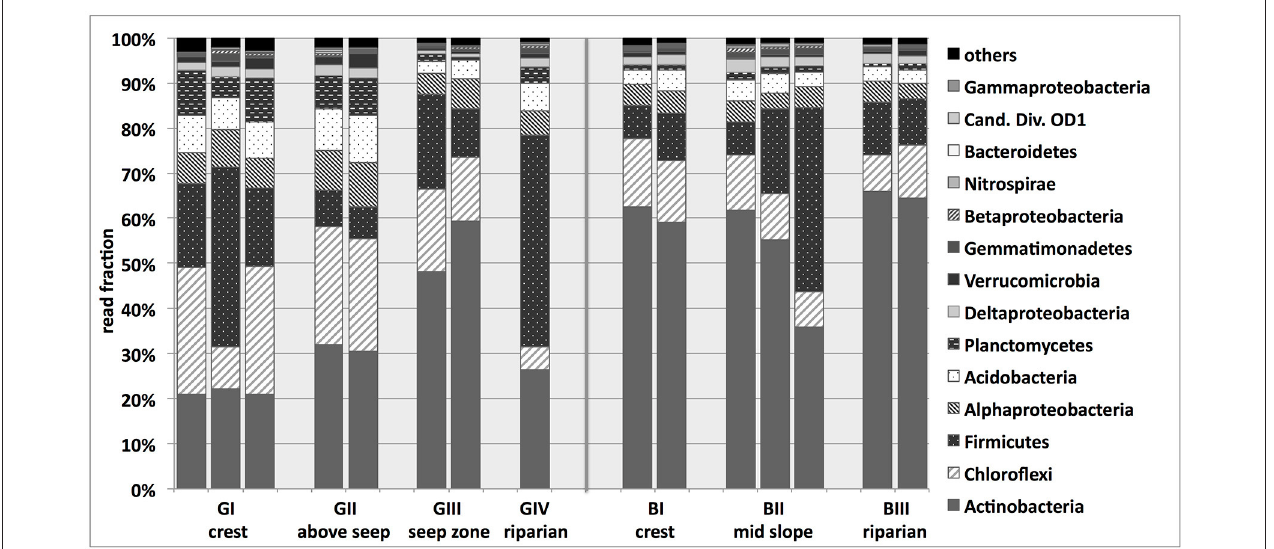
FIGURE 3 | Phlyum-level taxonomic classification of sequences obtained from bacterial 16S rRNA gene-targeted Illumina sequencing of savanna soil samples taken from 5 cm depth at different locations along the granitic (GI-GIV) and the basaltic (BI-BIII) catena. Cand. Div., Candidate Division. For some samples, replicates had to be excluded from further analysis of the normalized data set due to low read numbers. Results based on the non-normalized sequence data, including more soil replicates, are presented in Supplementary Figure 7.